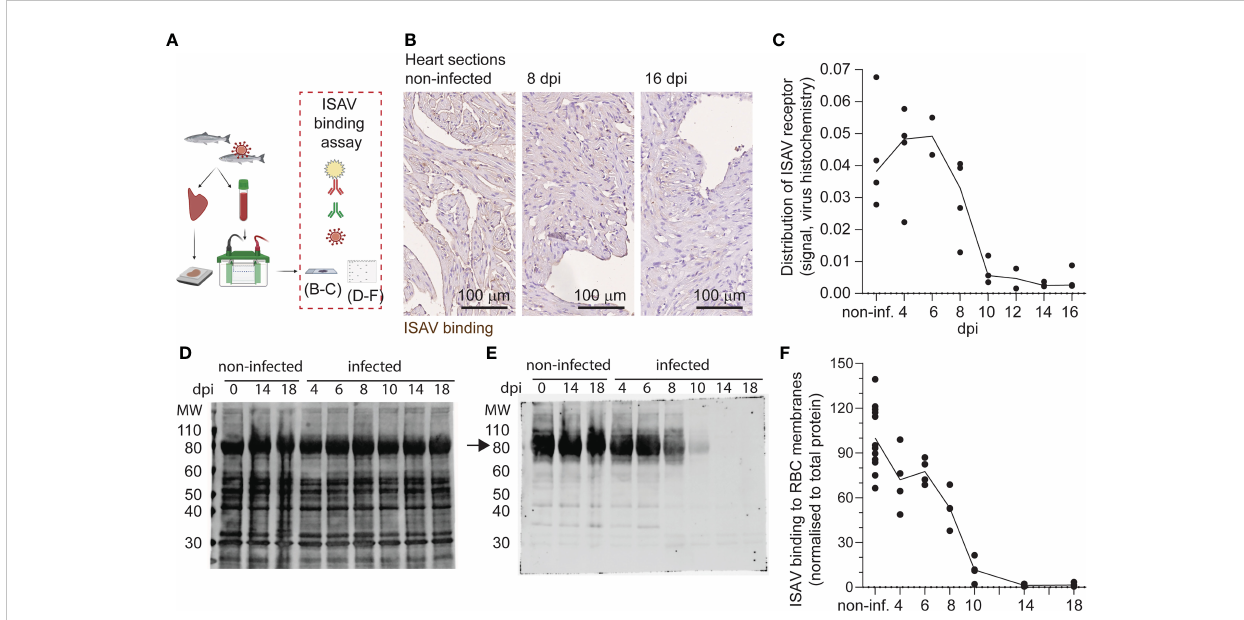
FIGURE 2 Like vascular endothelium, circulating erythrocytes in infected fi sh lose the ability to bind new ISAV. (A) The distribution of the ISAV receptor in heart tissues and membrane-enriched erythrocyte fractions was evaluated by serial incubation with ISAV antigen, mouse IgG 1 targeting HE (clone 3H6F8), fl uorescence- or HRP-conjugated secondary antibodies, and substrate if relevant. The illustration was created in Biorender.com. (B) Representative micrographs showing the ISAV receptor (brown) in hearts of non-infected and infected fi sh (8 and 16 dpi). Sections are counterstained with hematoxylin. Scale bars measure 100 m m. (C) Quanti fi cation of ISAV receptor signal in scanned heart sections. (D, E) Membrane-enriched erythrocyte lysates were separated by SDS-PAGE and blotted to nitrocellulose membranes, before evaluation of ISAV binding as described above. Representative blots show (D) total protein and (E) ISAV binding (arrow) to samples from non-infected fi sh harvested 0, 14, and 18 dpi and infected fi sh harvested 4, 6, 8, 10, 14, and 18 dpi. (F) Quanti fi cation of signal (4 fi sh per time point) normalized to total protein. (C, F) Data points represent individual fi sh. Lines connect median